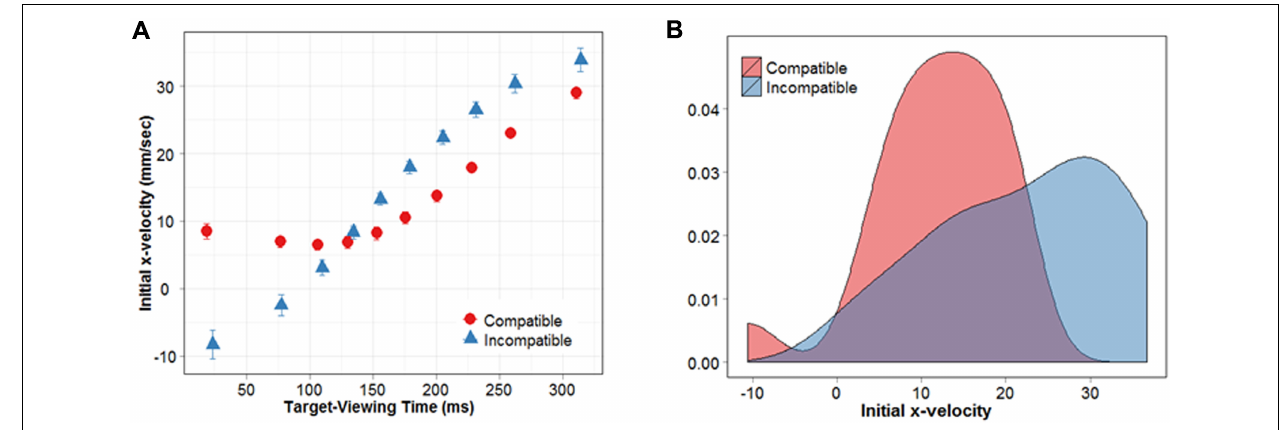
FIGURE 4 | (A) Initial x-velocity shown as a function of target-viewing time. (B) Distribution of initial x-velocities for MIT percentiles 6–8.